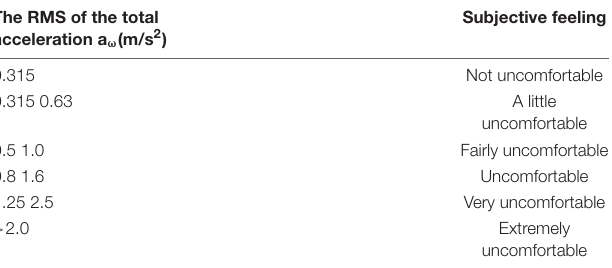
TABLE 1 | The root mean square (RMS) of total acceleration and subjective feeling of the human’s body. The RMS of the total acceleration a ω (m/s 2 )